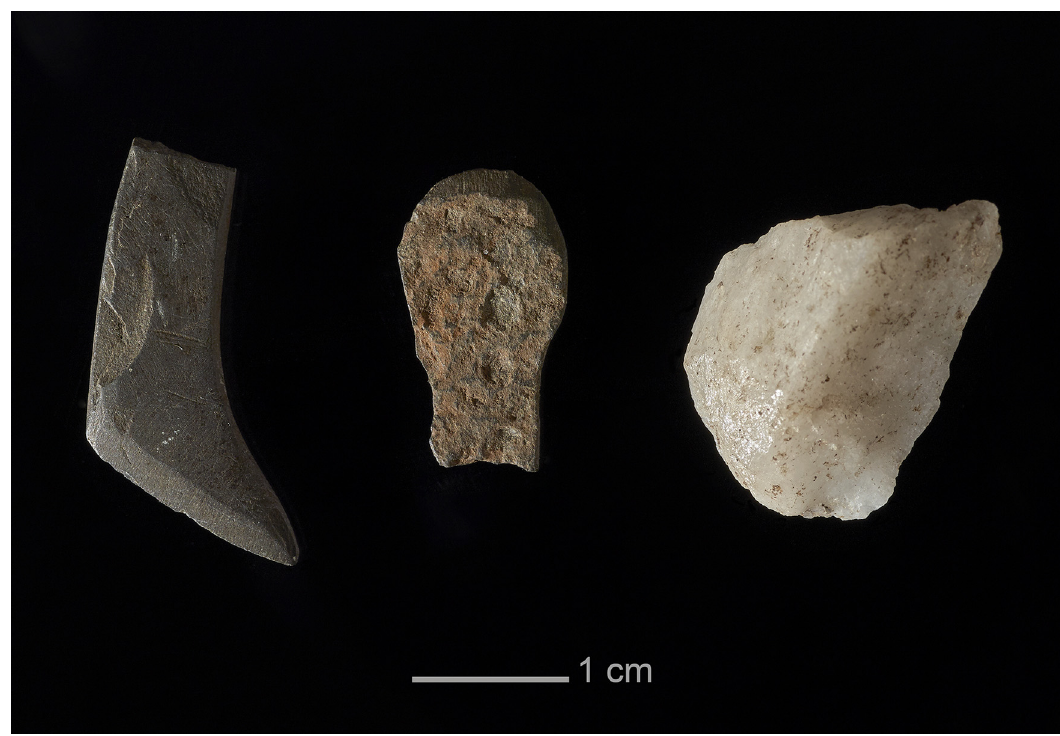
Figure 4: A “ miniature ” slate knife and two lithic scrapers, one atypical spoon - shaped in slate and one in coarse quartz, all from Rissebávti/Gressbakken Nedre Vest house 4. Photo by M. Karlstad, UiT – The Arctic University of